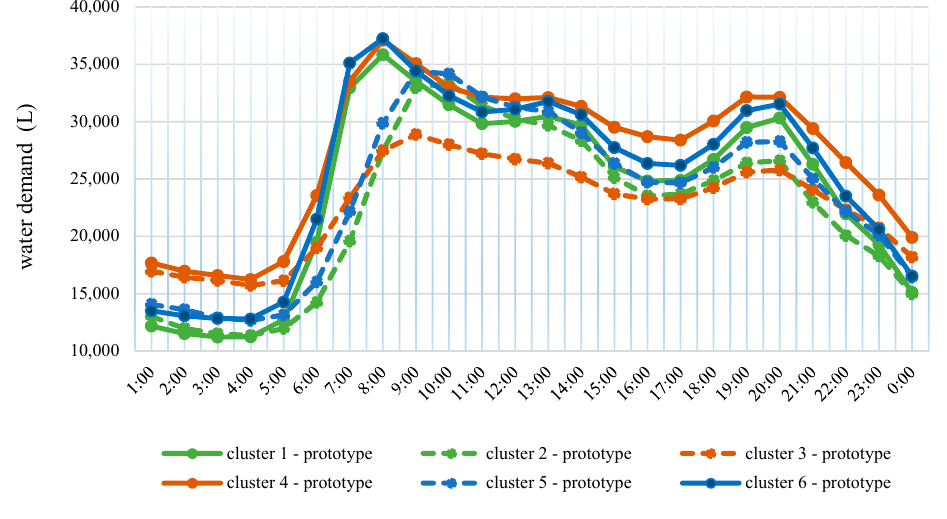
Figure 4. The k = 6 typical water demand patterns identified through the two-level clustering procedure. The cluster assignment is the same as the previous Figure 3.